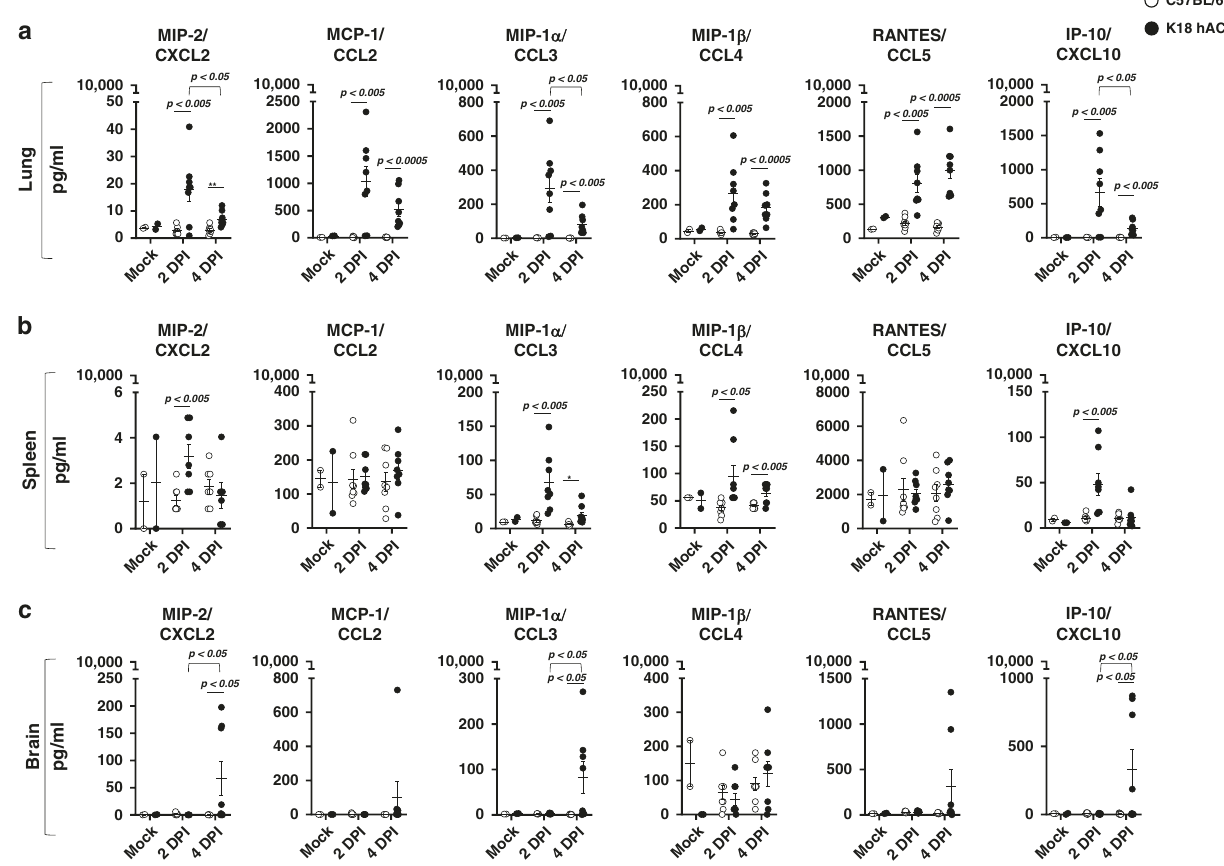
Fig. 2 SARS-CoV-2-infected K18 hACE2 transgenic mice show a marked chemokine storm in selected tissues. a Lung, b spleen, and c brain. Student ’ s t test, two-tailed, C57BL/6 vs. K18 hACE2 p < 0.05; p < 0.005; p < 0.0005; two-WAY ANOVA C57BL/6 or K18 hACE2 transgenic mice over time, p < 0.05; p < 0.005; p < 0.0005, M ± SEM, n = 8 mice (50:50 male:female per time-point studied, except mock n = 2 mice). DPI days post infection. Data are representative over two independent experiments. Source data are provided as a Source Data fi